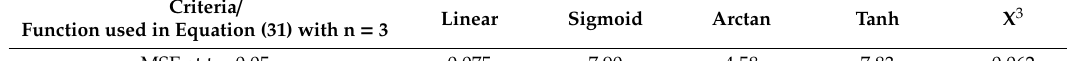
Table 4. Performance comparison of di ff erent function types used in Equation (31), whereby all are monotonic increasing functions. The polynomial function shows the better convergence compared to the other functions.